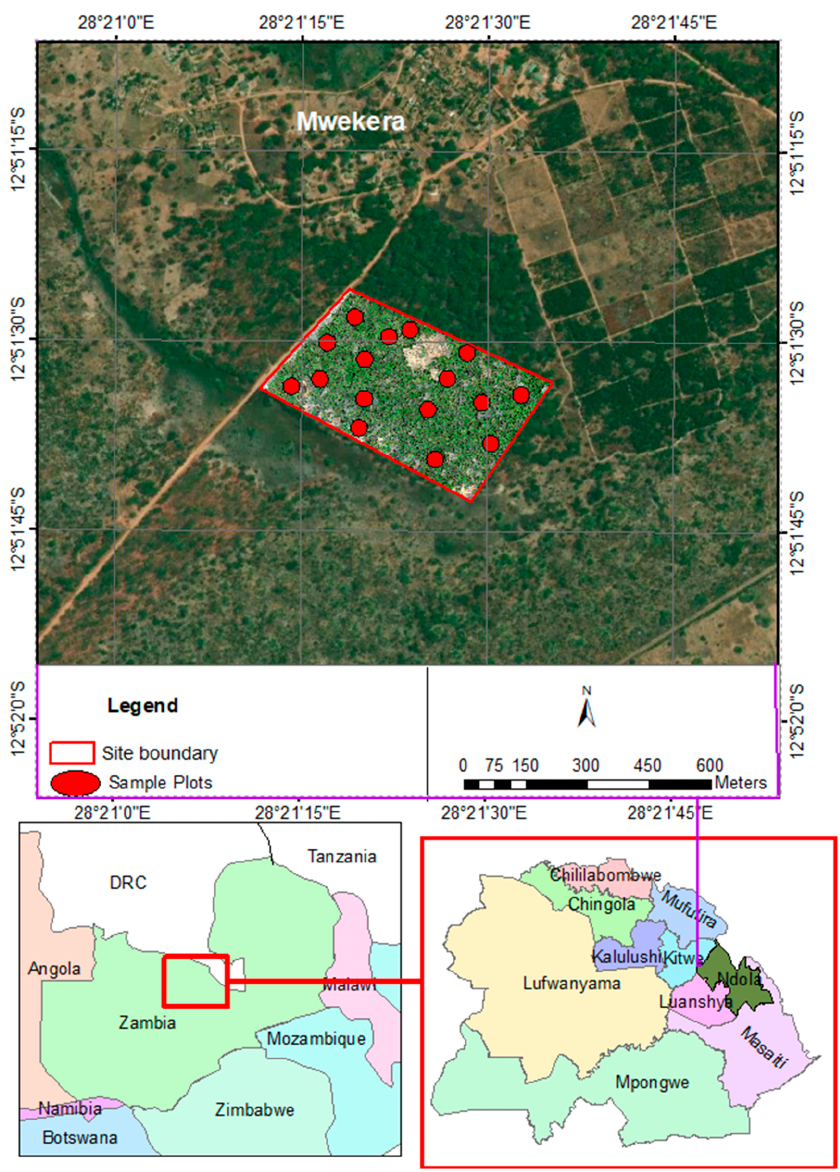
Figure 2. Study area